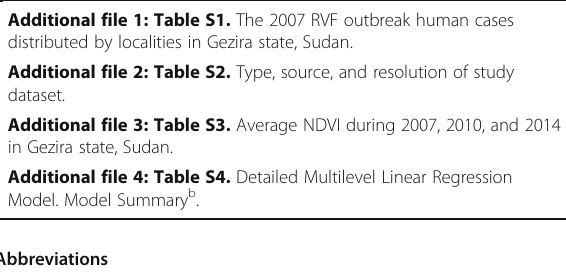
Additional file 1: Table S1. The 2007 RVF outbreak human cases distributed by localities in Gezira state, Sudan. Additional file 2: Table S2. Type, source, and resolution of study dataset. Additional file 3: Table S3. Average NDVI during 2007, 2010, and 2014 in Gezira state, Sudan. Additional file 4: Table S4. Detailed Multilevel Linear Regression Model. Model Summary b